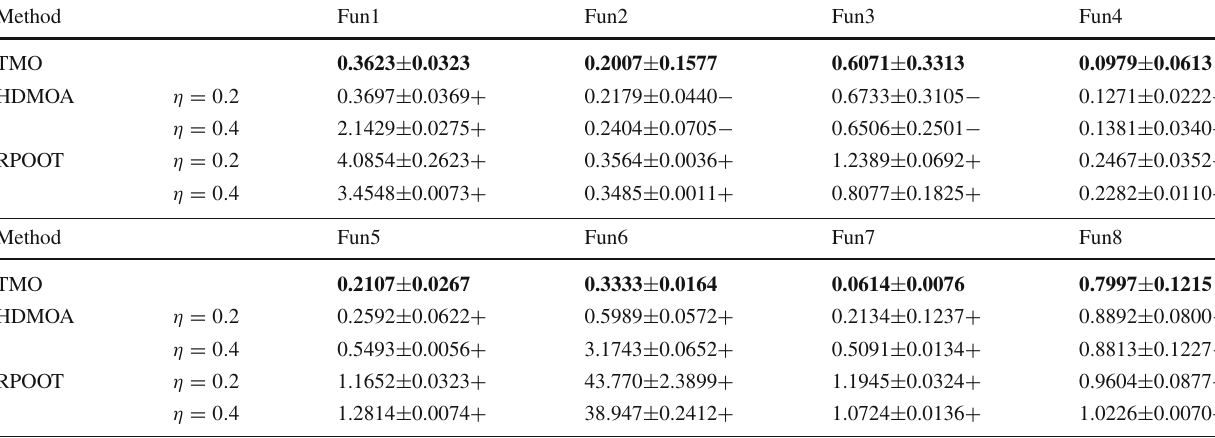
Table 9 RIGD comparison of three methods under stochastic environmental changes Method